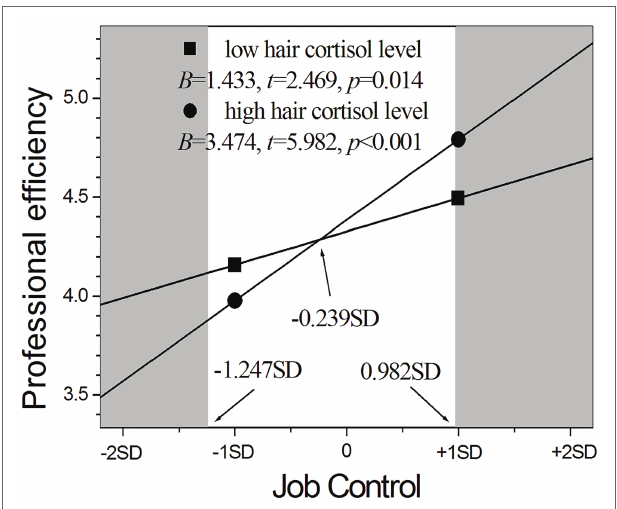
FIGURE 1 | The moderating role of hair cortisol in the relationship between job control and professional efficiency.